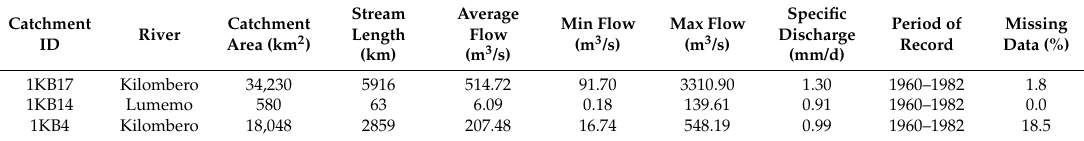
Table 1. Details of streamflow datasets used in this study.